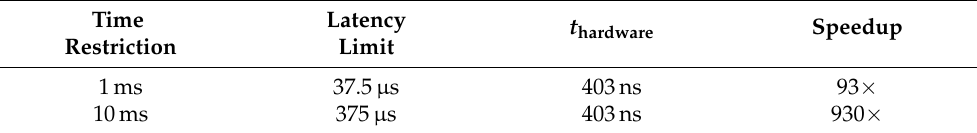
Table 3. Hardware speedup related to the time limits for the 1ms and 10ms latency constraints.